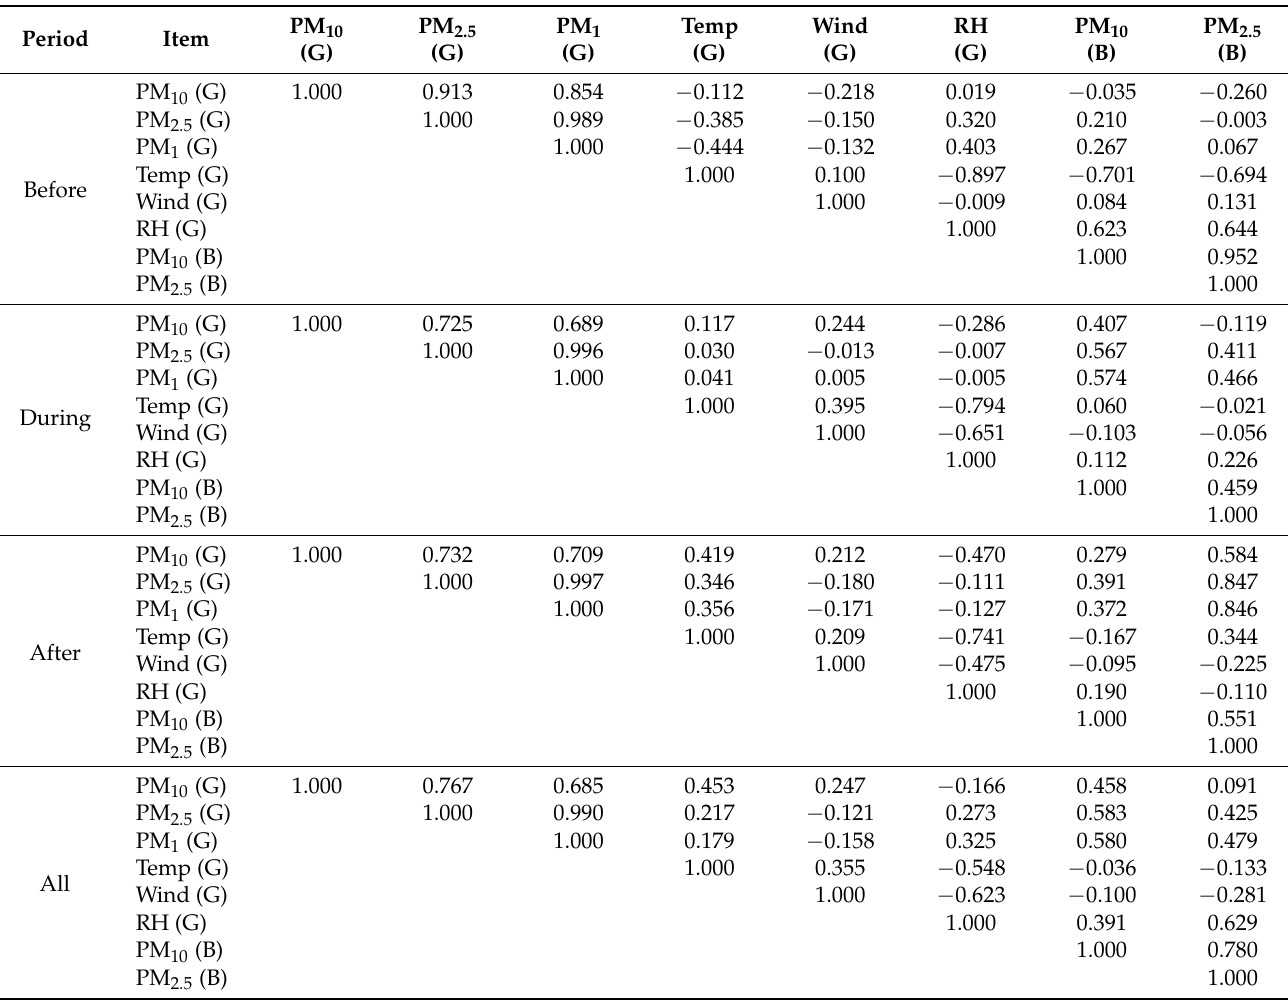
Table 2. Partial correlation matrix among PMs associated with meteorological parameters of Gangneung city (G) and PMs of Beijing city (B), before, during and after the dust